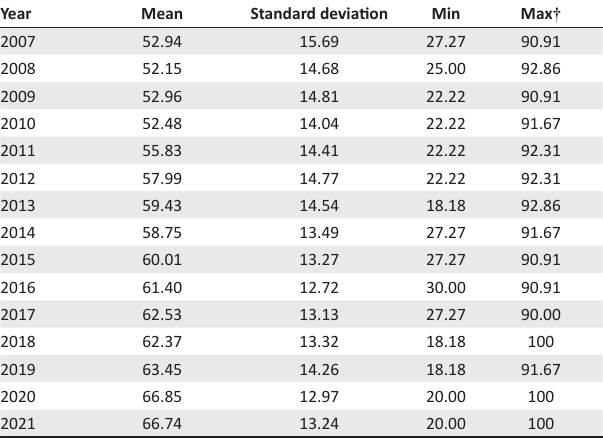
TABLE 4: Descriptive statistics for % independent non-executive directors.